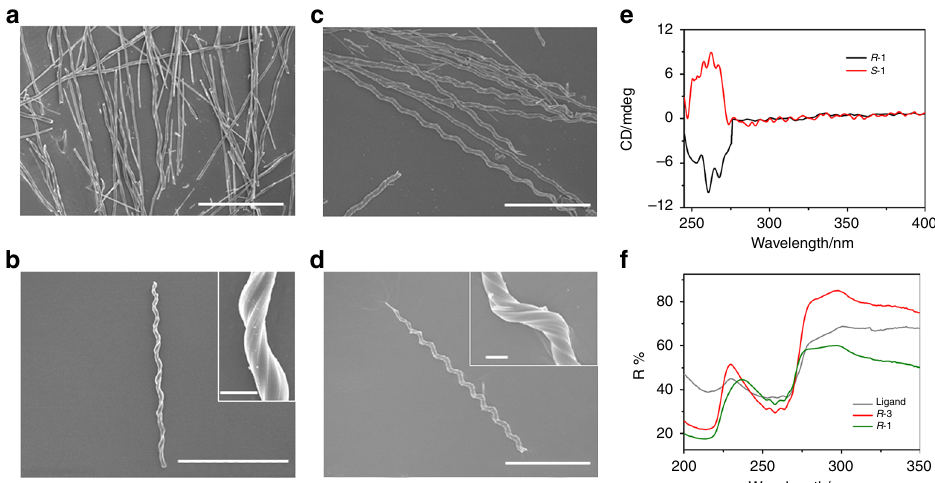
Fig. 2 SEM images, UV – Vis and CD spectra of helices. a , b SEM images of R -1 . c , d SEM images of S -1 . Scale bar: 100 μ m, inset: 5 μ m. e CD spectra of R -1 and S -1 . f Re fl ectance UV – Vis spectra of R -pempH 2 , helices of R -1 and rod-like crystals of R